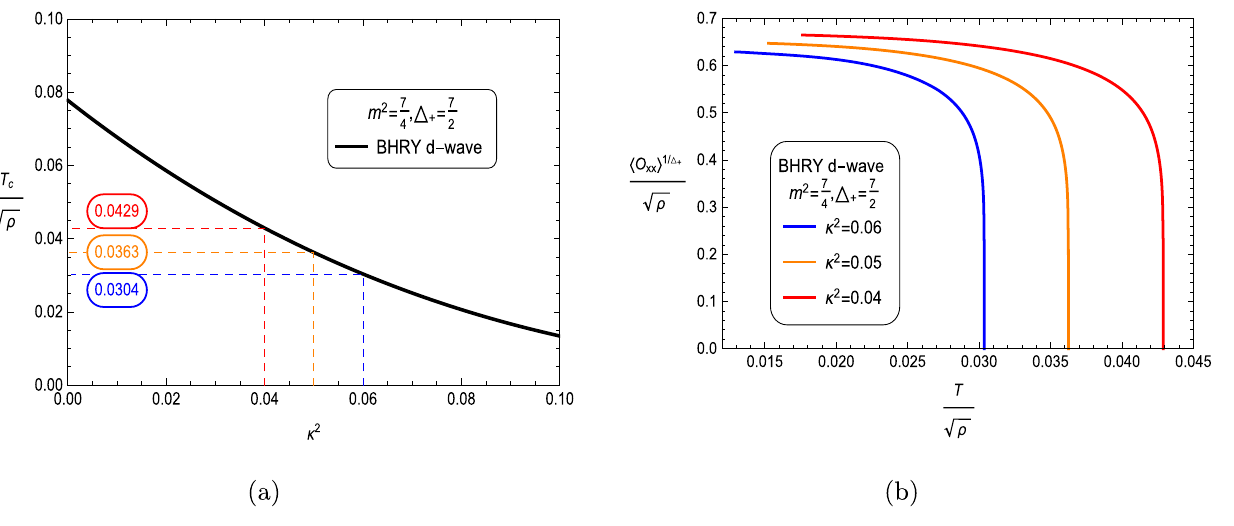
Fig. 2 The left figure depicts the change of critical temperature with backreaction κ 2 for m 2 = 7 / 4 in the BHRY d-wave superconduct- ing model. The right figure is the condensate as a function of tem- perature. Different colors correspond to different backreaction values,